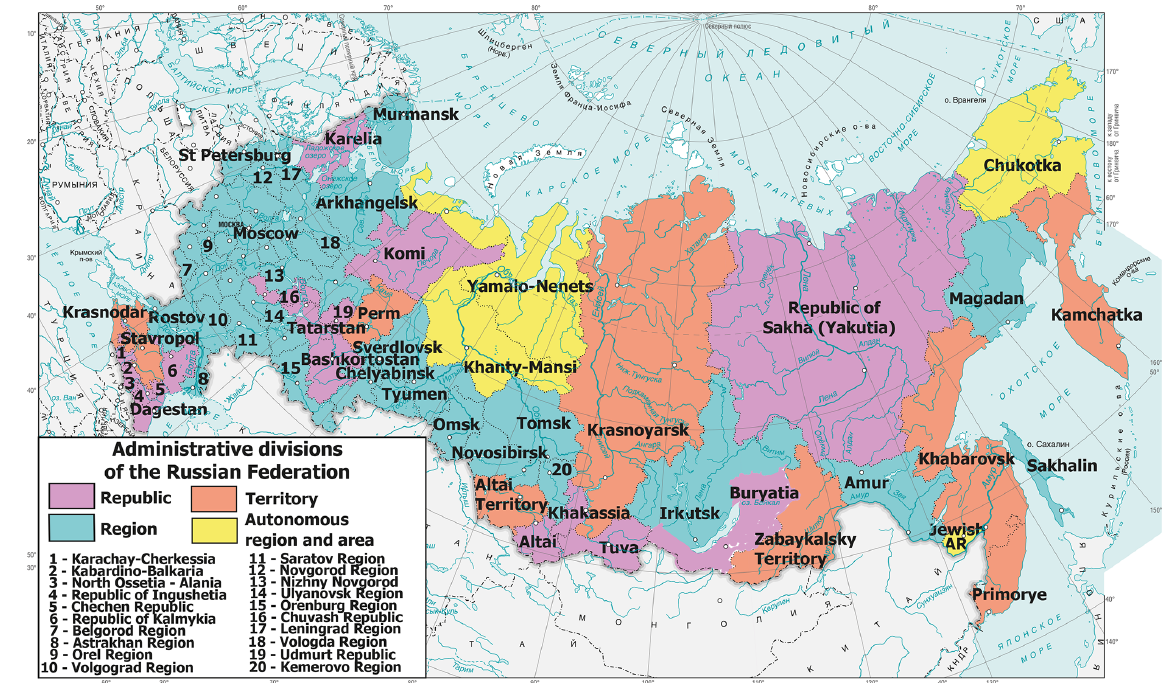
Figure 2. Federal regions of the Russian Federation (base map © DIK – Publishing House: Design. Information. Cartography).